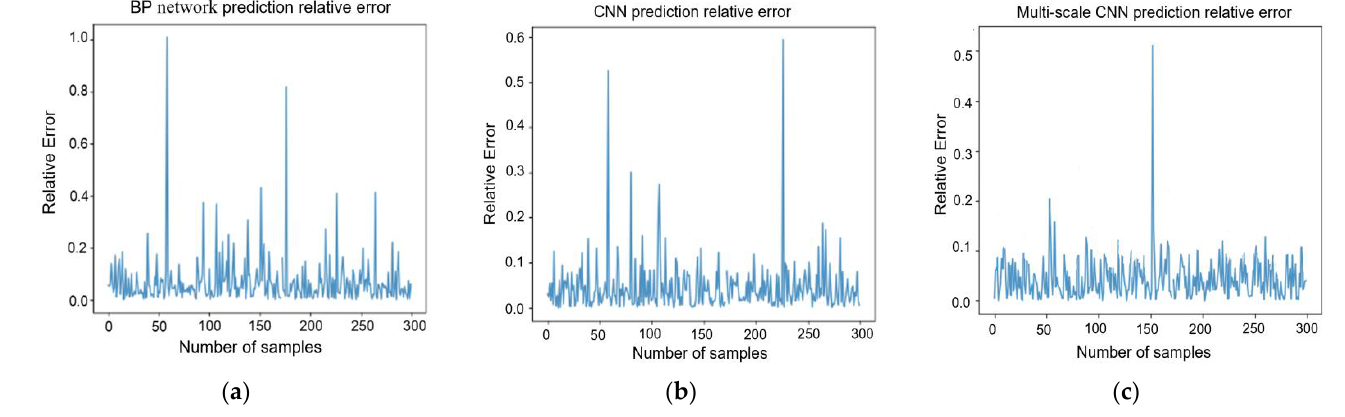
Figure 7. ( a ) Relative error between the predicted value and actual value of BP neural network in the test set; ( b ) relative error between the predicted value and actual value of convolutional neural network in the test set; ( c ) relative error between the predicted value and actual value of multi-scale convolutional neural network in the test set.